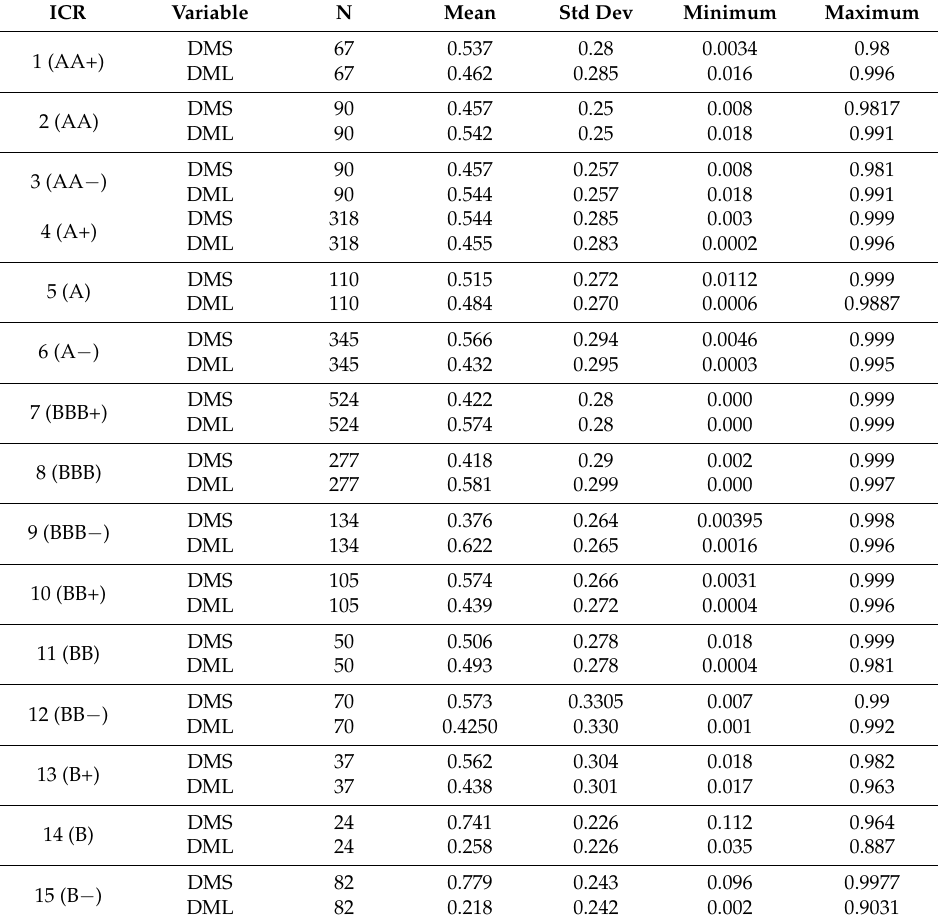
Table 4. Mean of shorter and longer debt maturity at each rating scale.